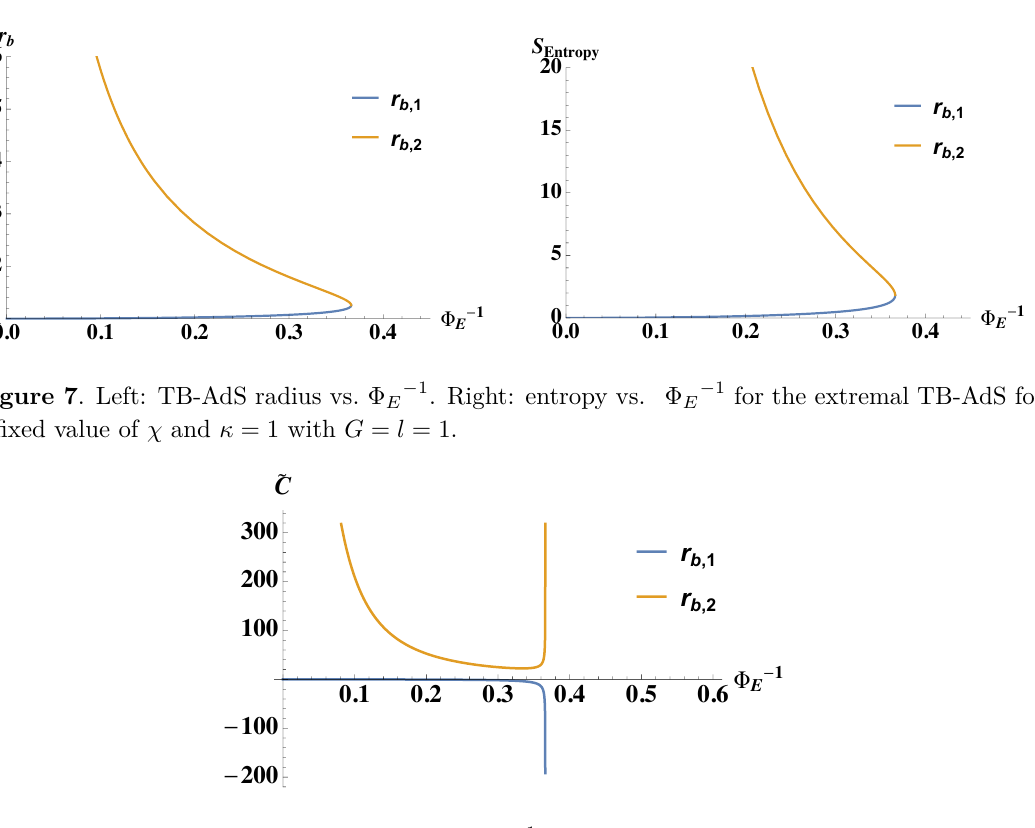
Figure 8 . “Heat capacity-like” quantity vs. Φ E − 1 for the extremal TB-AdS with a fixed χ and κ = 1